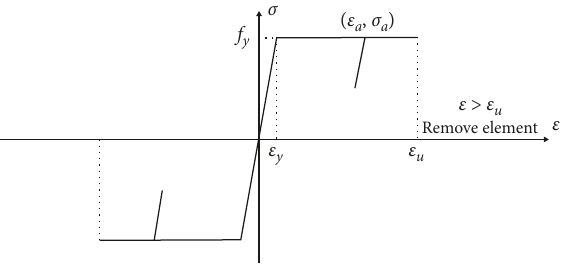
Figure 2: Stress-strain curve of